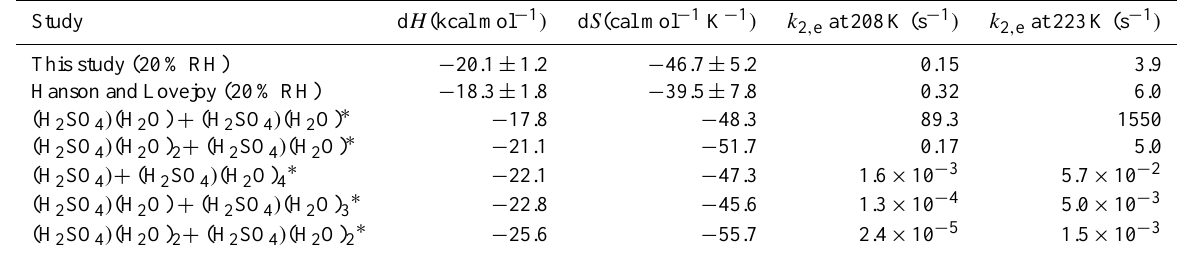
Table 2. Thermodynamic properties (d H and d S) and evaporation rates of the sulfuric acid dimer from this study and from the literature. Study d H (kcal mol − 1 ) d S (cal mol − 1 K − 1 ) k 2 , e at 208K (s − 1 ) k 2 , e at 223K (s − 1 ) This study (20% RH) − 20.1 ± 1.2 − 46.7 ± 5.2 0.15 Hanson and Lovejoy (20% RH) − 18.3 ± 1.8 (H 2 SO 4 ) (H 2 O) + (H 2 SO 4 ) (H 2 O)